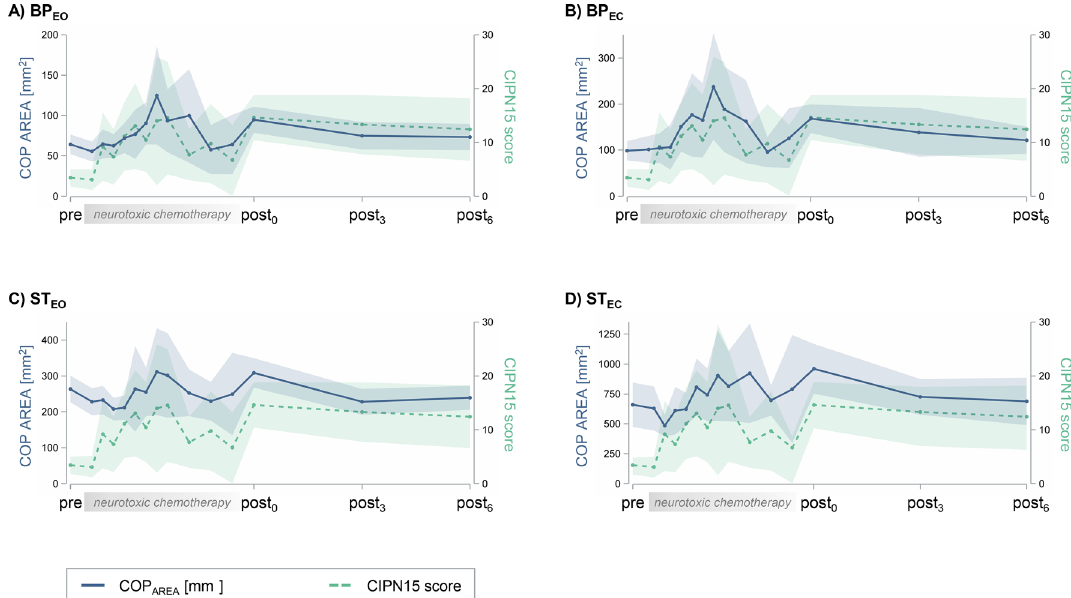
Figure 2. Postural control and CIPN symptoms over time. The time-scale of the data points in the ‘neurotoxic chemotherapy’ portion of the x-axis correspond to the chemotherapy cycles. Since the minimum interval between two postural control measurements was two weeks, but the individual lengths of the chemotherapy cycles in our study varied between one to three weeks, the reported sample sizes per cycle ( in brackets ) differ as follows: 32 ( 2 ), 34 ( 3 ), 34 ( 4 ), 32 ( 5 ), 18 ( 6 ), 21 (7 ), 7 ( 8 ), 14 ( 9 ), 13 ( 11 ), 10 ( 13 ), 7 ( 15 ). The blue line graphs show the averaged course (+ 95% CI, blue shading) of postural control (COP AREA ) over the entire study period in the following standing conditions: (A) bipedal stance with eyes open (BP EO ), ( B ) bipedal stance with eyes closed (BP EC ), ( C ) semi-tandem stance with eyes open (ST EO ), ( D ) semi-tandem stance with eyes closed (ST EC ). The turquoise line graphs show the averaged EORTC-CIPN15 scores (+ 95% CI, turquoise shading) at the corresponding measurement